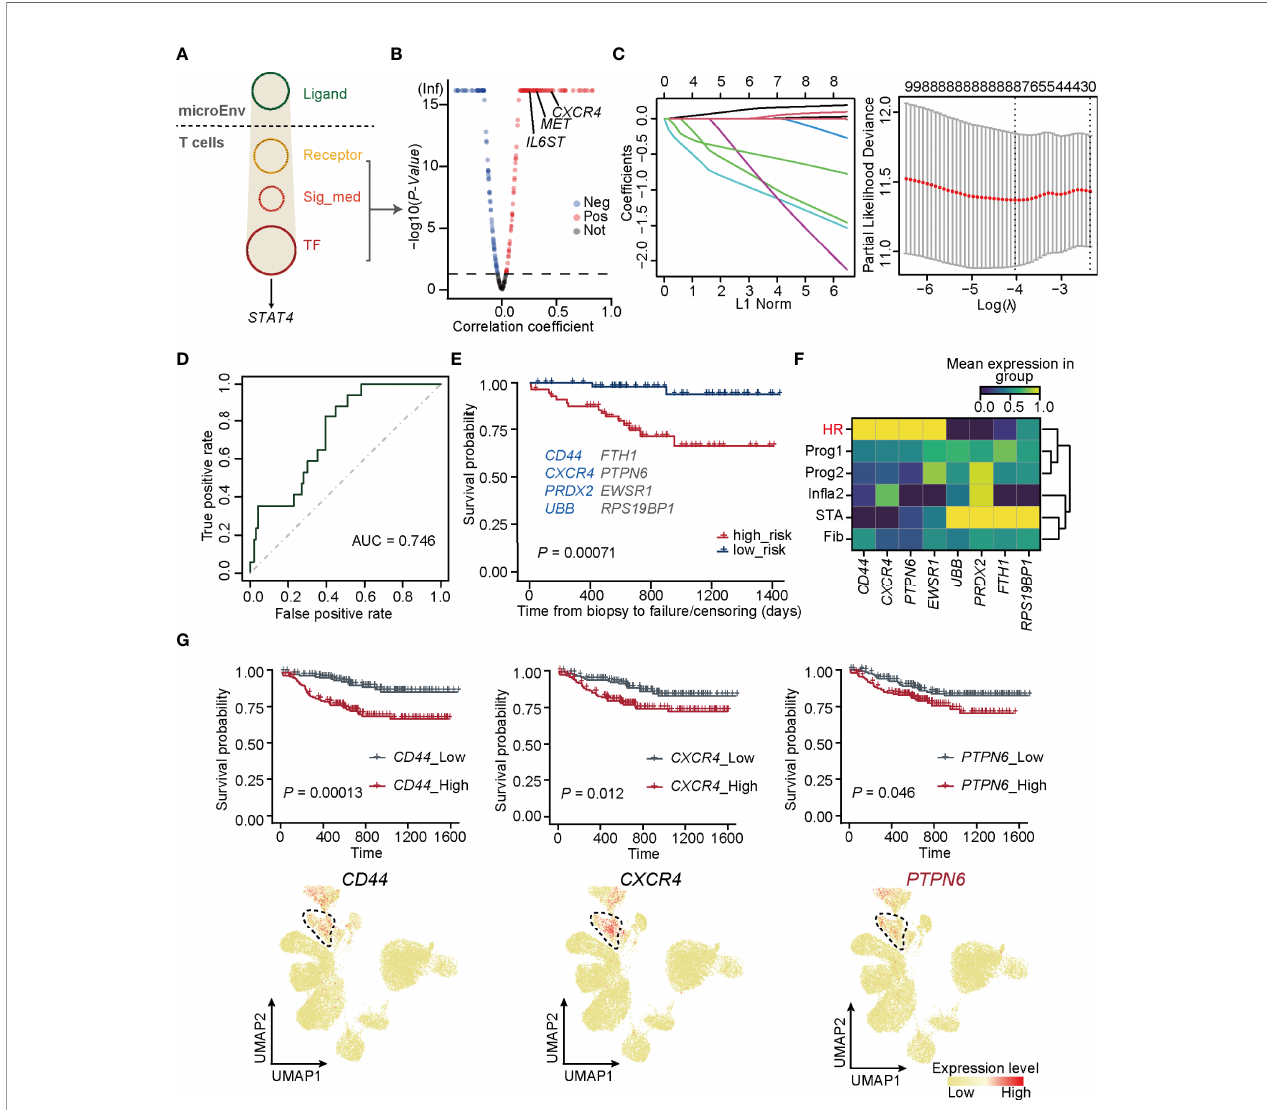
FIGURE 4 | PTPN6 is a novel regulator inducing STAT4 signaling in T cells. (A) Upstream regulatory networks targeting of STAT4 in T cells form HR. Sig_med, signaling mediator; TF, transcriptional factors; MicroEnv, microenvironment. (B) Scatter plot showing negative and positive correlations between STAT4 and its upstream-regulators. The red, blue, and gray dots indicate upstream regulators that were considered to be positive, negative, and no correlation, respectively. (C) The coef fi cient plot of the LASSO model (left panel) and the selection of the tuning parameter in LASSO logistic regression analysis (right panel). (D) ROC curves for allograft loss diagnosis prediction in the validation cohorts. € The survival plot of validation cohorts with predicted high and low risk of graft failure. Genes marked in blue are known to be relevant to graft rejection and those in gray were newly identi fi ed. (F) Matrix plot showing the expression level of optimal genes in each rejection state. (G) The survival plot (top panel) and UMAP plot (bottom panel) of CD44 , CXCR4 , and PTPN6 showing the relative expression level in each rejection